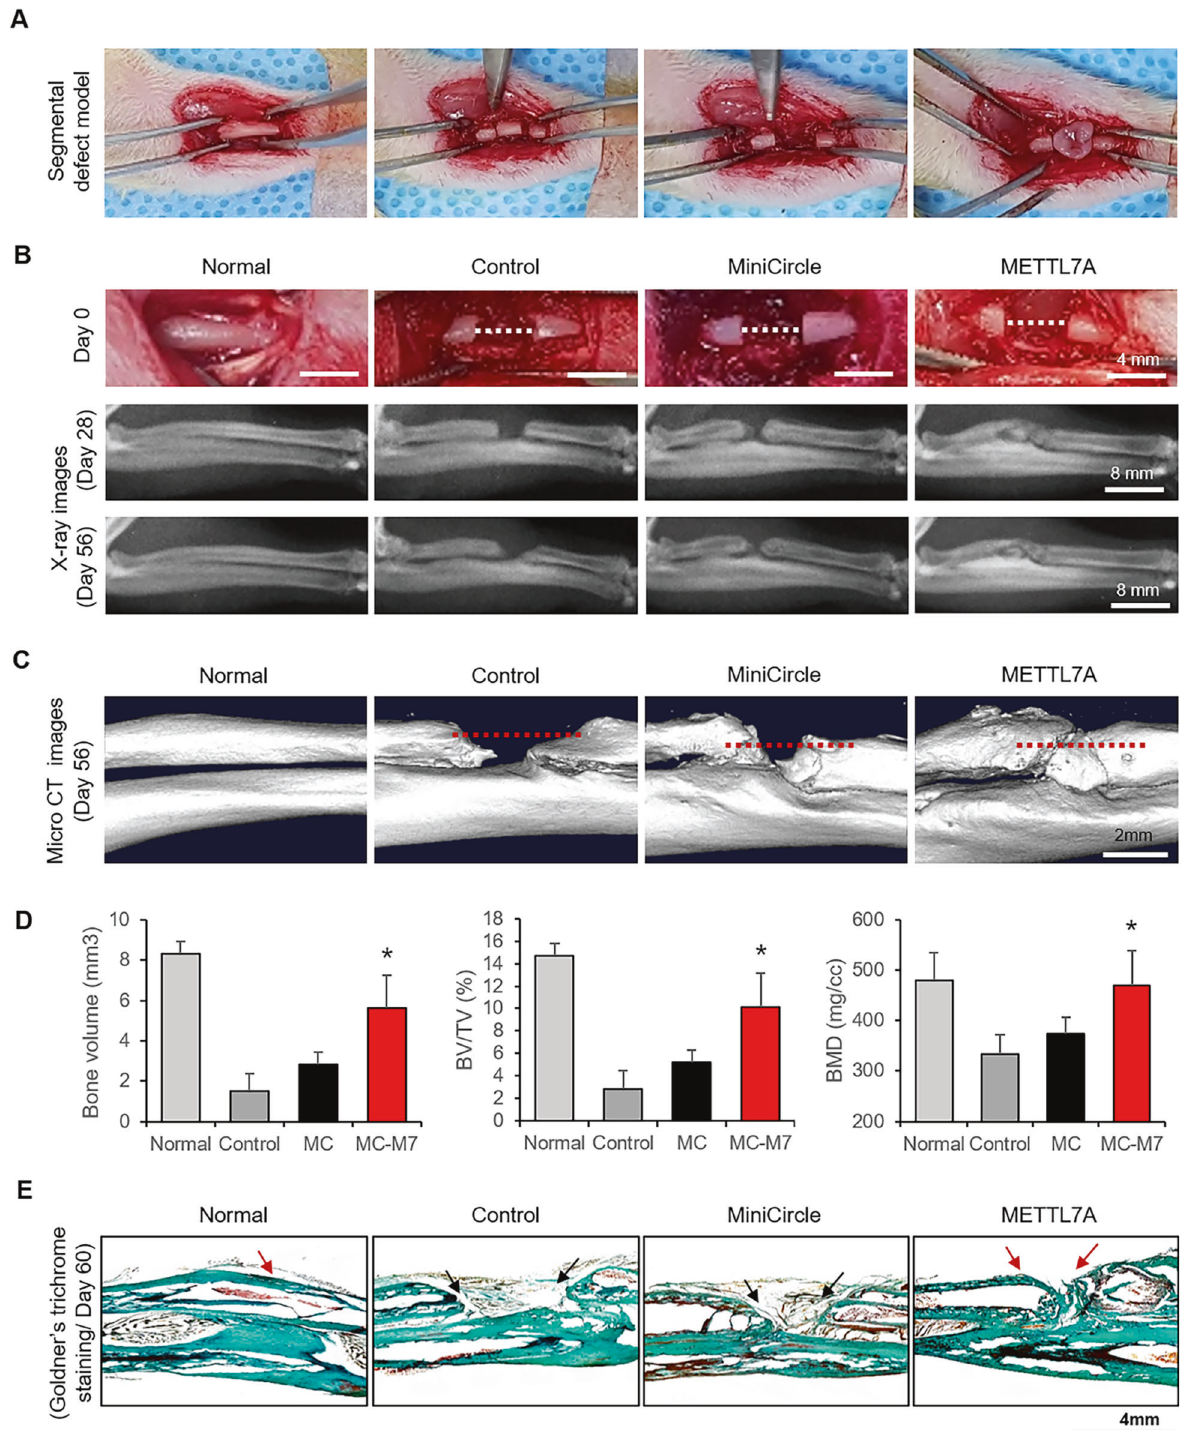
Fig. 5 In vivo new bone formation in segmental bone defect models. A Creation of critical-size segmental long-bone defect in immunosuppressed rat. Length of the defects was 4 mm. hBMSCs were implanted with fi brin glue into segmental defects of rats created in the radius of right forelimb. B Radiographic images of segmental defects on days 28 and 56 after the implantation of hBMSCs. C MicroCT images of segmental long-bone defects at 56 days after cell implantation. D After 56 days, bone volume (BV, mm 3 ), BV/TV (bone volume/total volume, %), and BMD (bone mineral density, mg/cc) were evaluated by MicroCT. E Goldner ’ s trichrome staining of healed segmental defects on day 56 post implantation of hBMSCs. Statistical processing was performed in comparison with the control group. Data were presented as mean ±standard deviation (SD, N = 4). NS: no signi fi cant difference, * p < 0.05, ** p < 0.01. Normal: no surgery and no cell implantation; control: surgery only without cell implantation; MiniCircle (MC): minicircle control vector-transfected hBMSCs implantation; MC-METTL7A (MC-M7): METTL7A-transfected hBMSCs